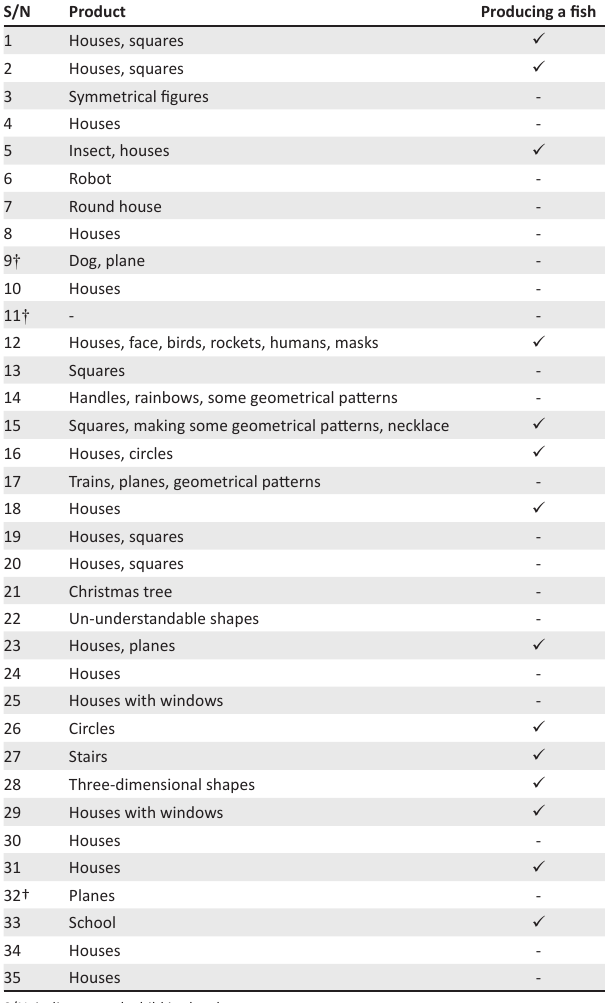
TABLE 1: Children’s productions with colour boards in the second